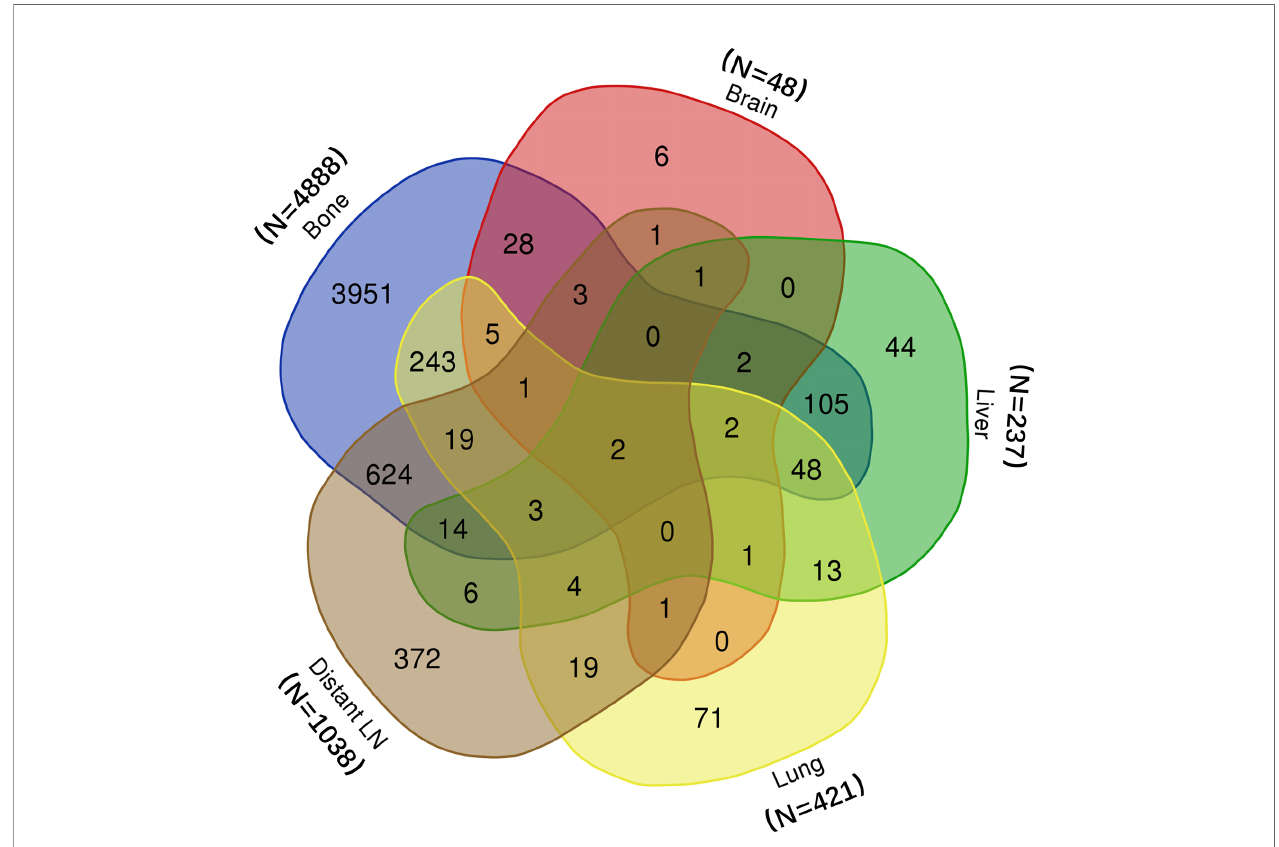
FIGURE 1 | Venn diagram of distribution of metastatic